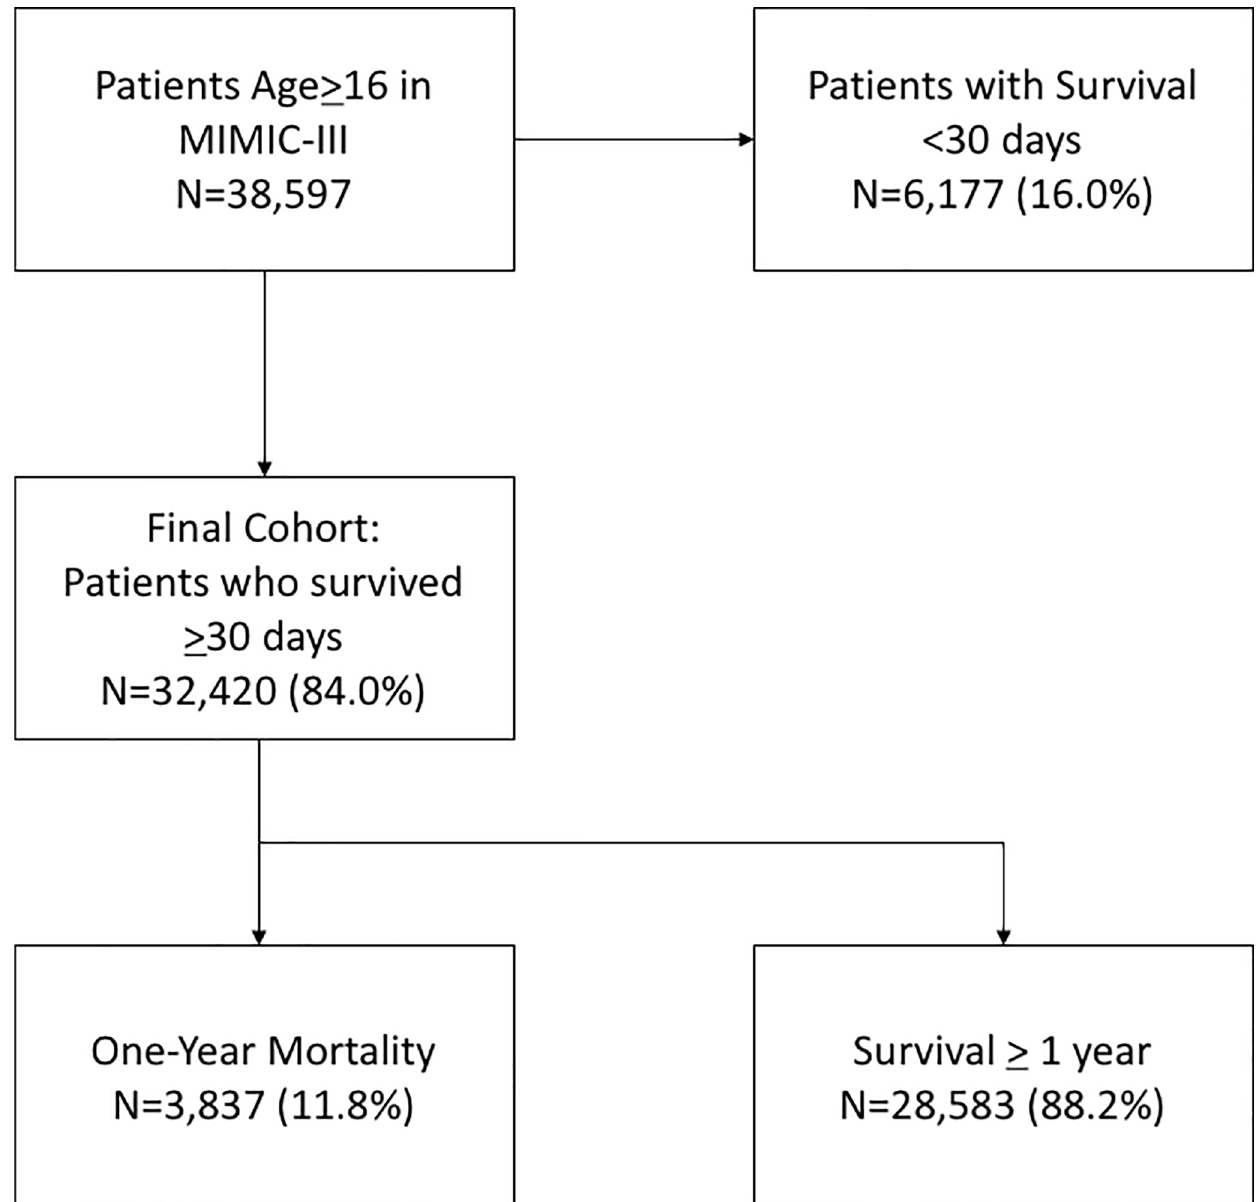
Fig 1. Flow diagram showing initial selection of cohort and excluded